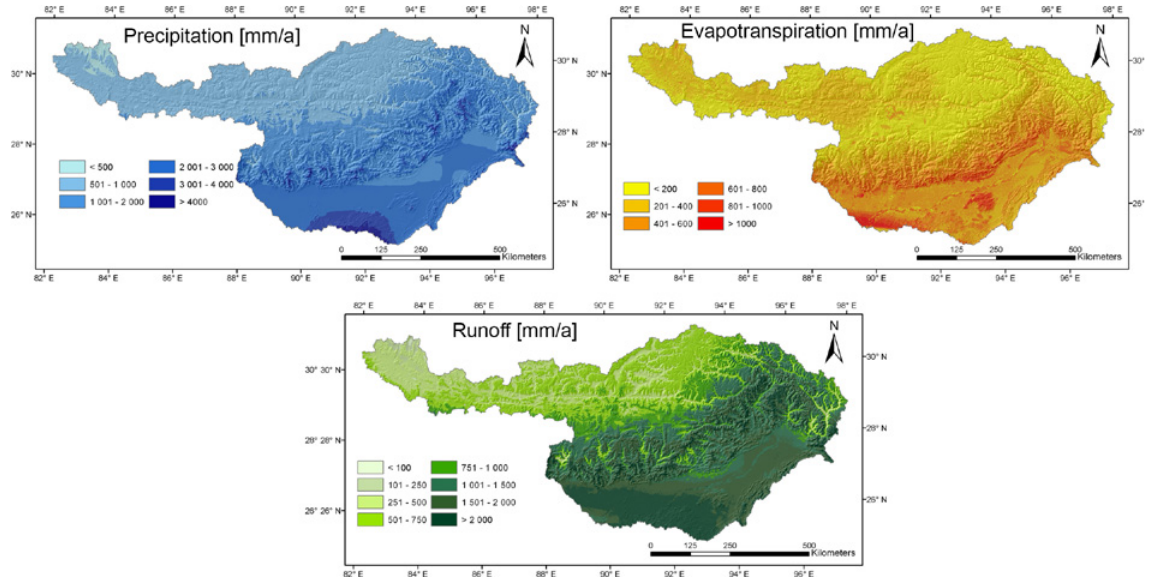
Figure 7. Modelled distributed water balance in the UBRB in using CLM ERA data as meteorological drivers for the period